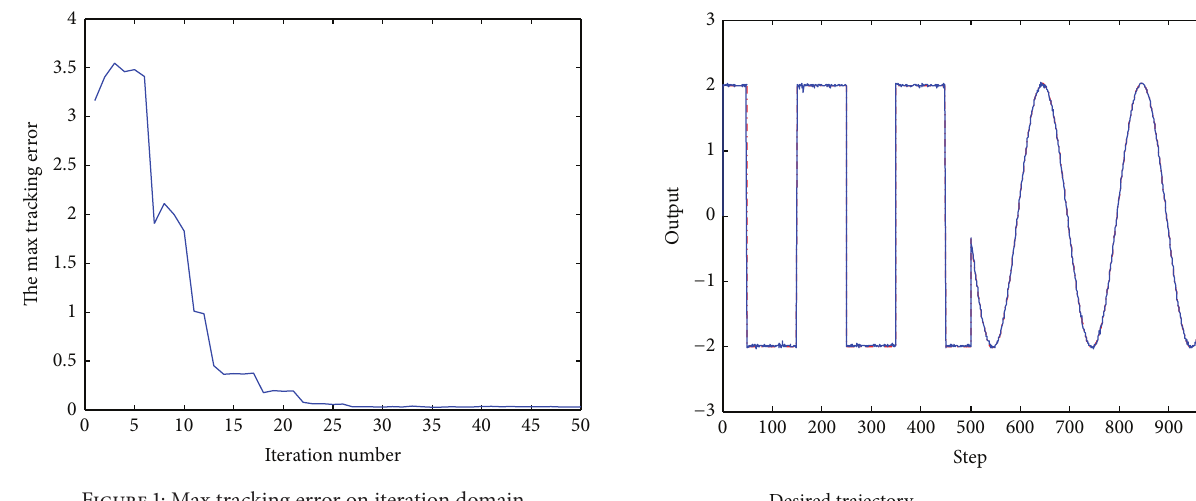
Figure 1: Max tracking error on iteration domain.